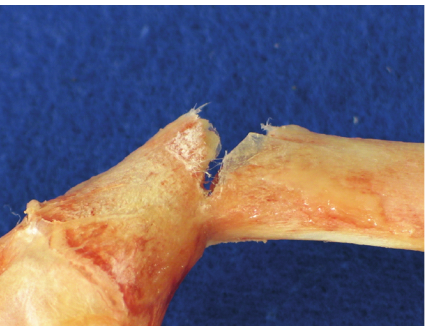
FIGURE 2: Metacarpal fracture line passes from the dorsal cortex to the volar cortex short oblique or transverse (AO A2 fracture